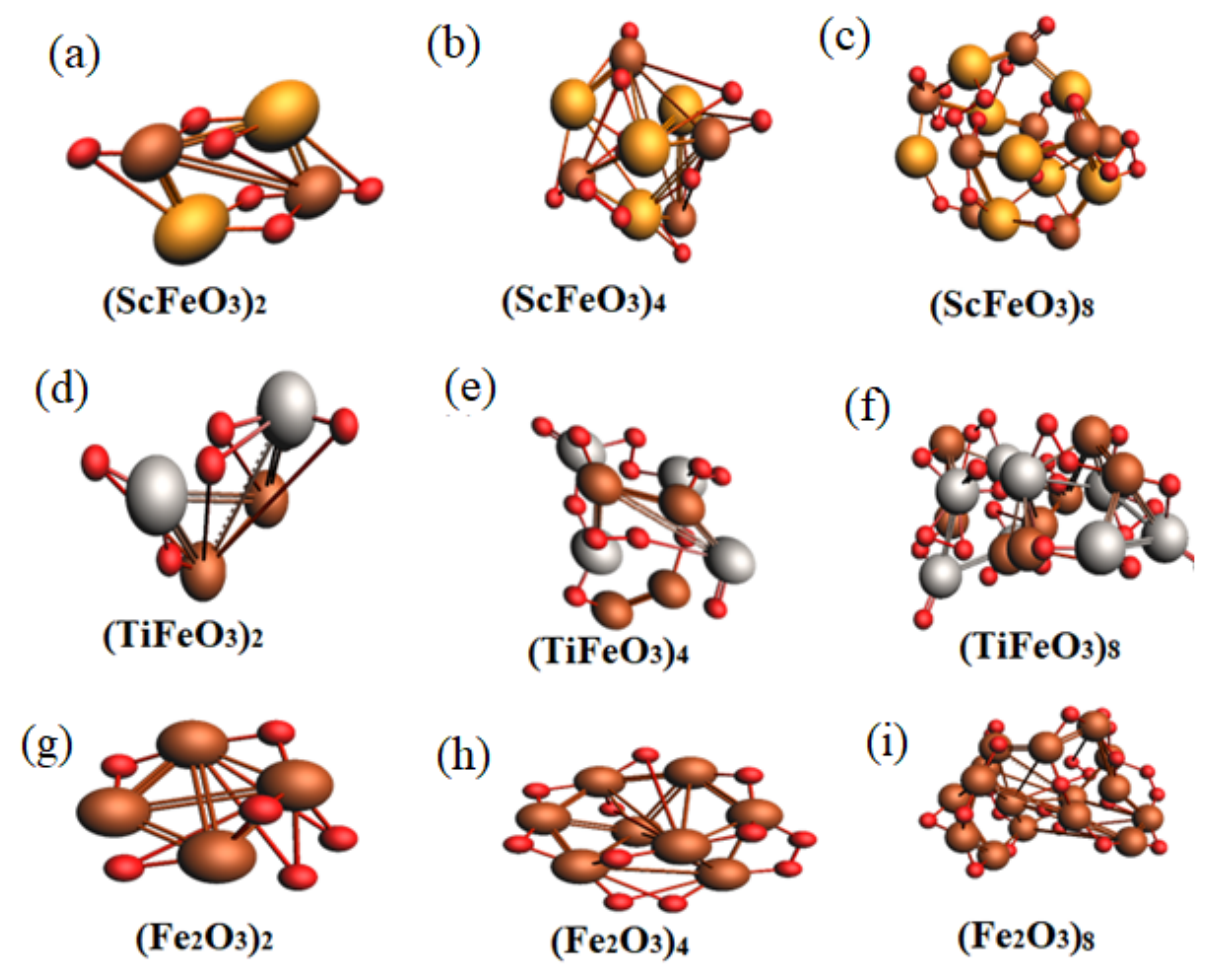
Figure 1. Optimized structures of (TMFeO 3 ) x molecular clusters for x = 2, 4, 8 and TM = Sc, Ti, Fe showing geometry of the clusters ( a ) (ScFeO 3 ) 2 , ( b ) (ScFeO 3 ) 4 , ( c ) (ScFeO 3 ) 8 , ( d ) (TiFeO 3 ) 2 , ( e ) (TiFeO 3 ) 4 , ( f ) (TiFeO 3 ) 8 , ( g ) (Fe 2 O 3 ) 2 , ( h ) (Fe 2 O 3 ) 4 , and ( i ) (Fe 2 O 3 ) 8 . Table 1. This Table Explains Tabular form of Spin, Total Optimized Energy, Fermi Energy at Optimized Energy, Binding Energy, and Formation Energy for all Calculated